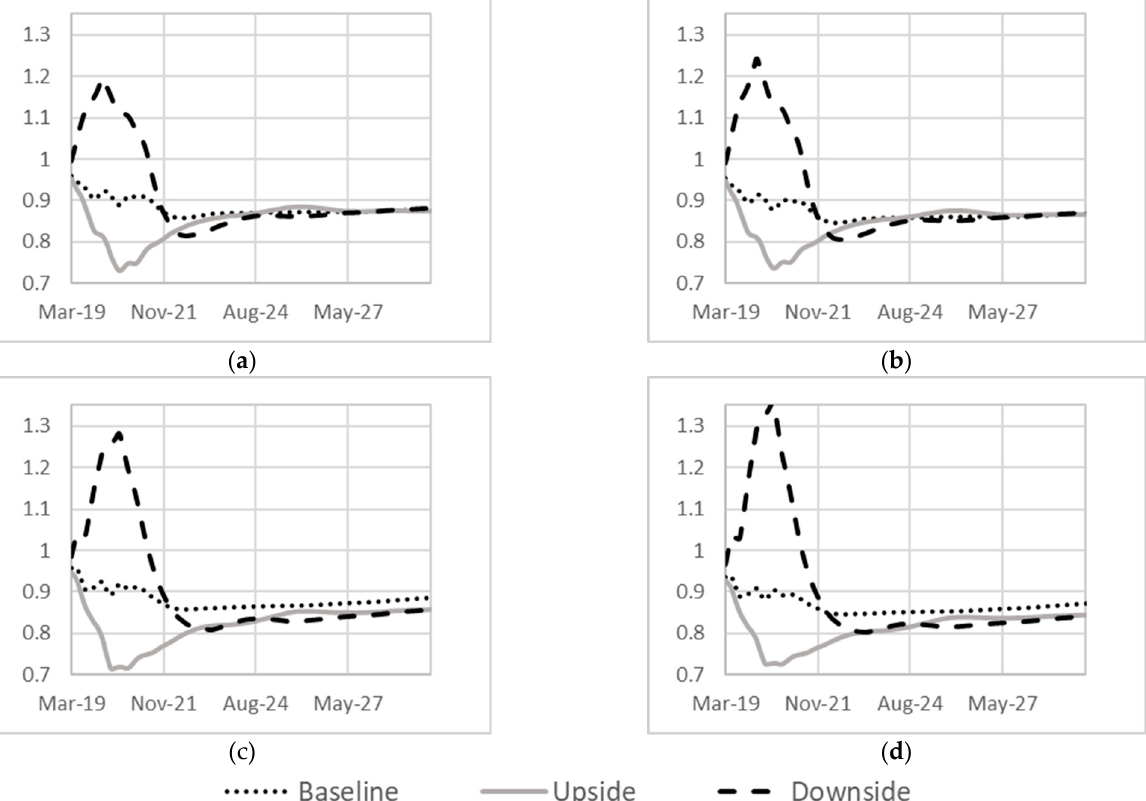
Figure 5. Macroeconomic scalar for PCR, GLM-PCR, REG, and GLM with baseline, upside, and downside macroeconomic scenarios. ( a ) PCR; ( b ) GLM-PCR; ( c ) REG; ( d ) GLM-REG.